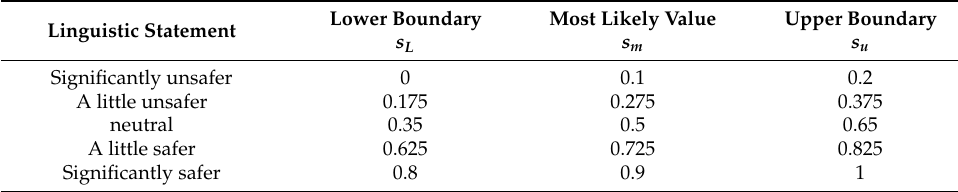
Table 5. Linguistic statements translated into fuzzy numbers.